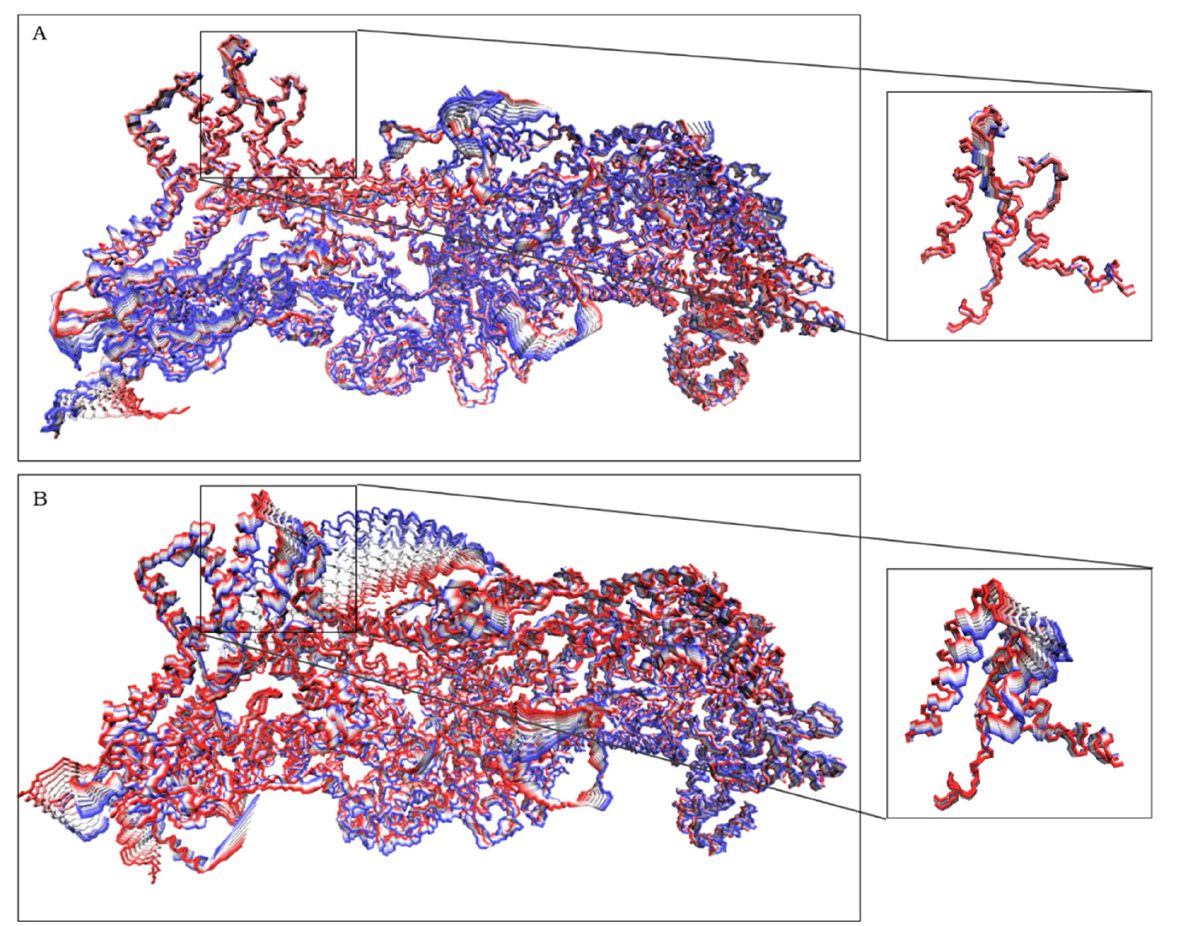
Figure 2. Projections of the trajectories from both replicas over the first vector for complex WT ( A ) and complex R87C ( B ). On the right are highlighted residues 80–120 from CYFIP2 and 131–161 from WAVE1. Ten frames per trajectory are shown from the highest positive (red) to the highest negative (blue) eigenvalues.